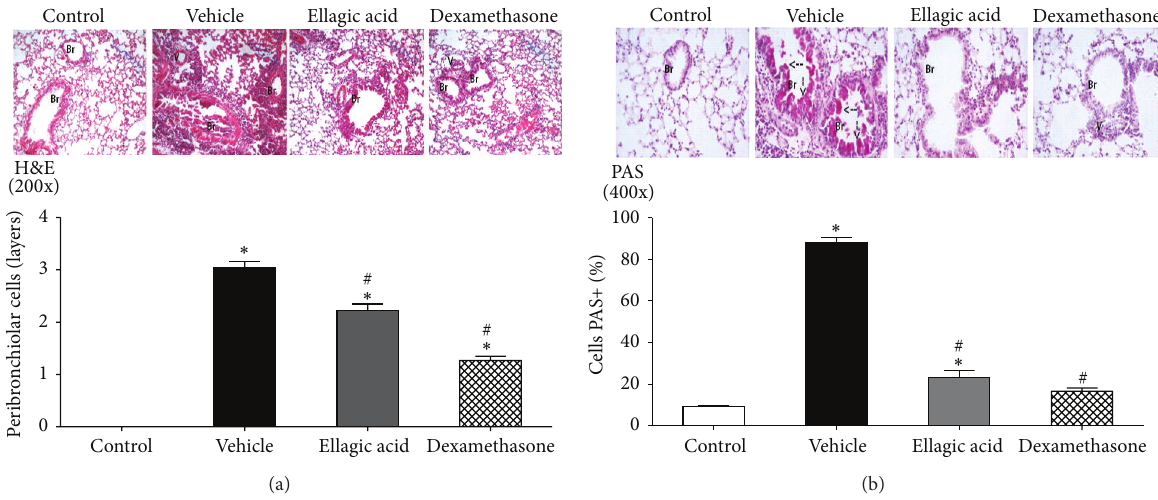
Figure 3: Effect of the therapeutic treatment with ellagic acid on lung inflammation and mucus secretion. Mice were treated with ellagic acid (10mg/kg) or dexamethasone (1mg/kg) or vehicle (water). One group of animals received vehicle (control group). Lung tissue sections were obtained at protocol day 21 and stained with H&E (original magnification: 200x) and the inflammation was quantified (a). Lugs tissue sections were also stained with PAS reagent (original magnification: 400x) and bronchial PAS-positive cells were quantified (b). Arrows indicate examples of mucus-containing (magenta) goblet cells. Results represent the mean ± SEM of two or more independent experiments with three mice per group. ∗ 𝑃 < 0.05 compared with control group; # 𝑃 < 0.05 compared with ovalbumin + vehicle group. Br: bronchus and V: